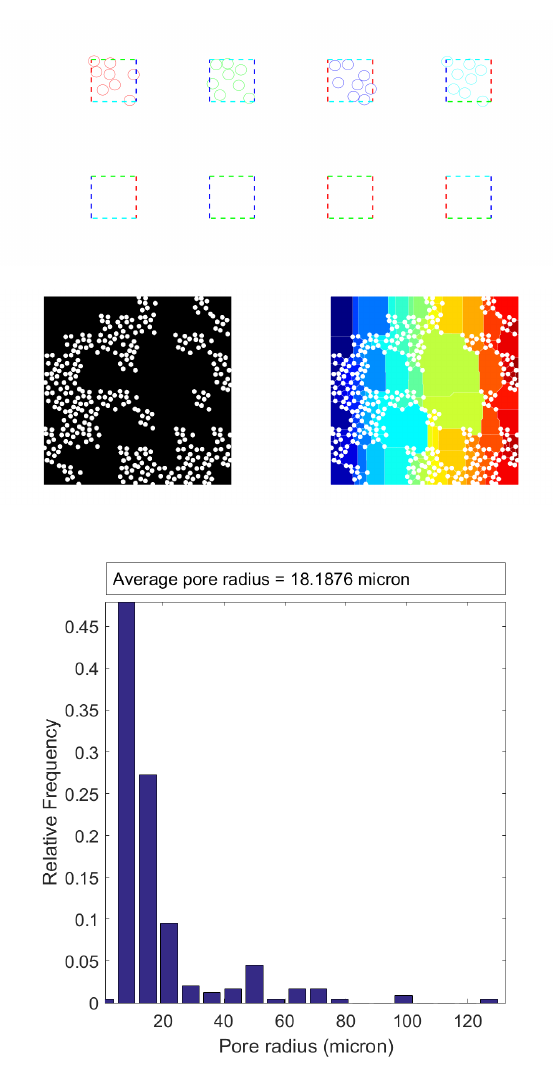
Figure 8. Artifitial tiling 10 × 10 from basic set in- cluding 8, 8, 8, 8, 0, 0, 0, 0 equal-sized